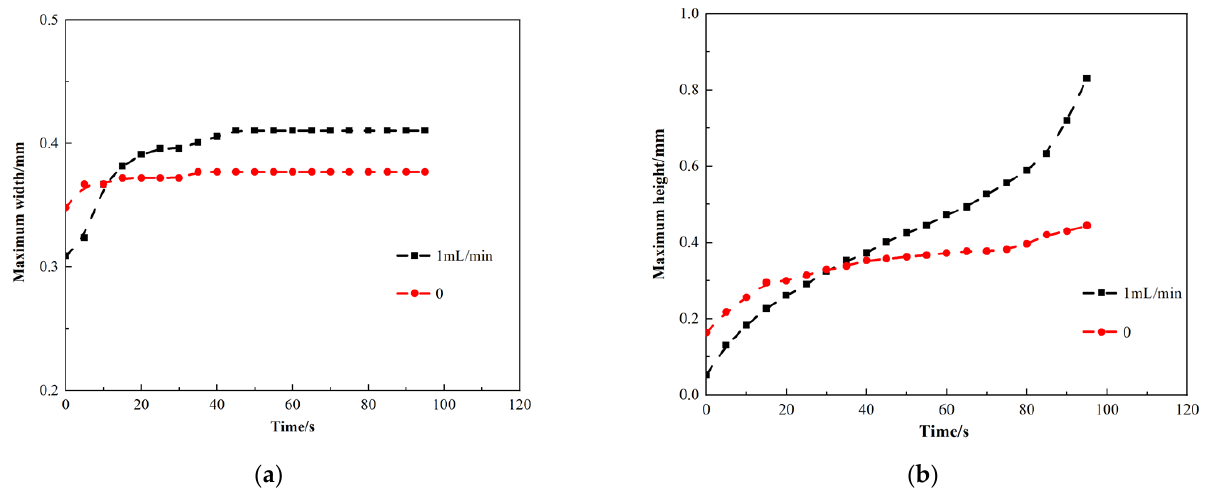
Figure 5. Change of oil drop size under different flow rate. ( a ) Comparison of maximum width of oil drop; ( b ) Comparison of maximum height of oil drop.